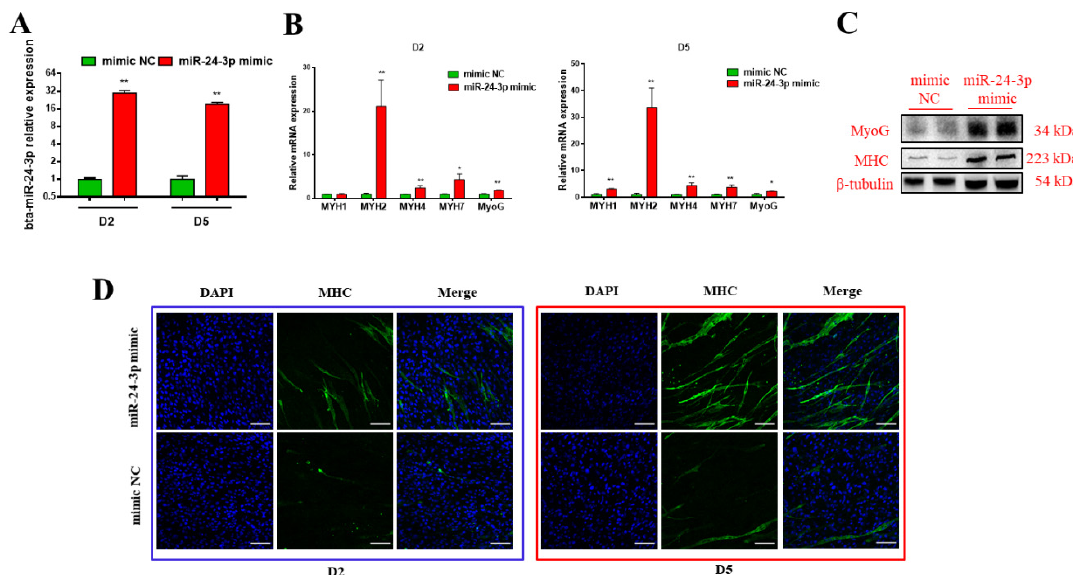
Figure 2. The expression of bta-miR-24-3p during the myogenic differentiation of bovine PDGFR α - progenitor cells. ( A ) bta-miR-24-3p expression 48 h after miR-24-3p mimics transfection, determined by qRT-PCR. ( B ) Transcript levels of myogenin and MHCs detected by qRT-PCR on D2 and D5. ( C ) Western blot evaluating the protein levels of myogenin and MHC 96 h following differentiation. ( D ) MHC-positive cells (green) on D2 and D5 of myogenic differentiation, visualized by immunofluorescence. Scale bars represent 100 µ m. All data are represented as mean ± standard deviation (SD,) based on at least three independent experiments for each treatment. * p < 0.05 and ** p <